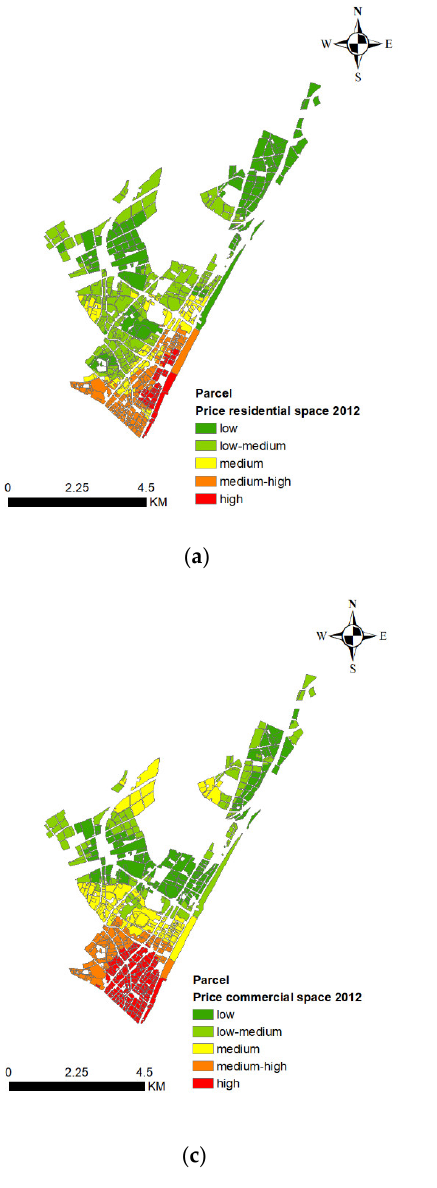
Figure 3. ( a – d ) Floor-space prices for residential and commercial for years 2012 and 2015 at parcel level; ( a ) average price for residential space (2012); ( b ) average price for residential space (2015); ( c ) average price for commercial space (2012); and ( d ) average price for commercial space (2015).